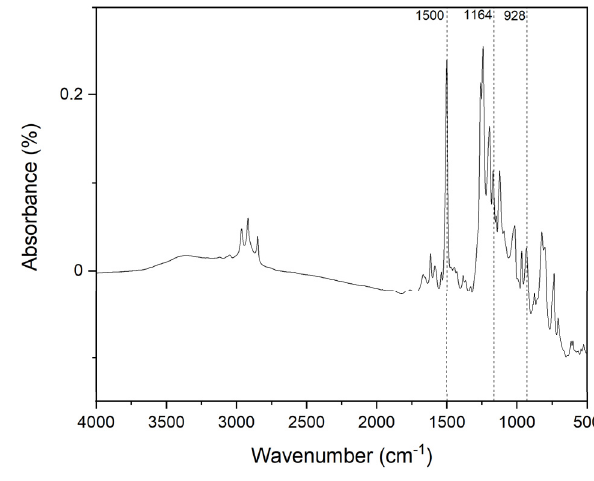
Figure 4. FT-IR spectrum of BAF-oda-fu.